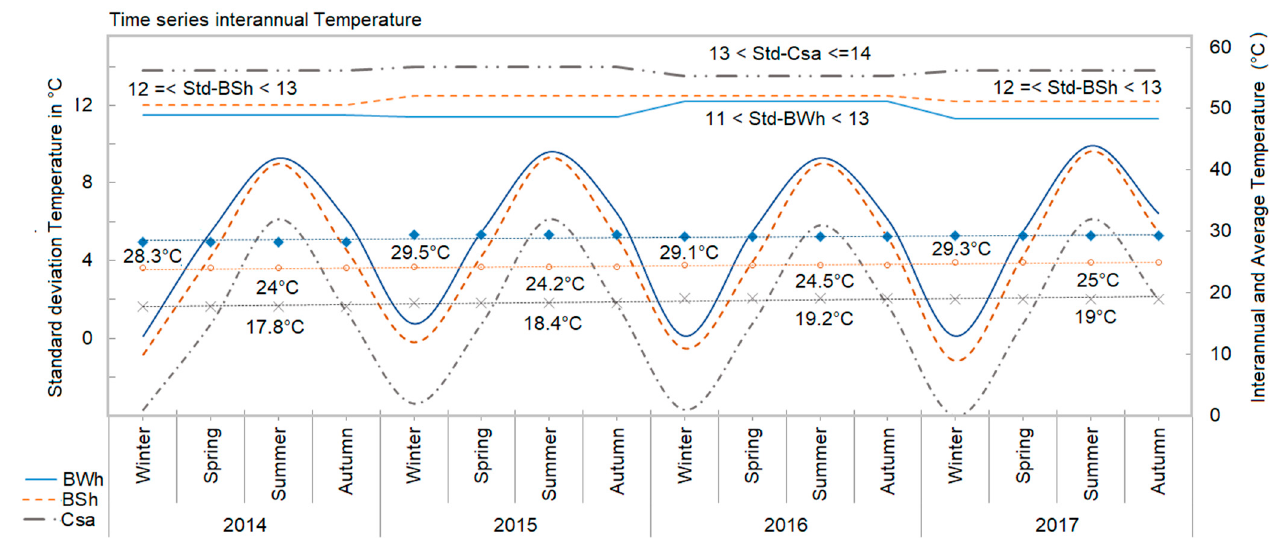
Figure 3. Time series interannual temperature data obtained from the study area. Standard deviation (Std) is a measure variation or dispersion of the temperature. According to the legend solid lines, dashed, and dash-dotted lines represent interannual time series of temperature in BWh (blue), BSh (brown), and Csa (gray) respectively. Left axis indicates standard deviation of annual temperatures around average temperature which is scaled on the right axis.